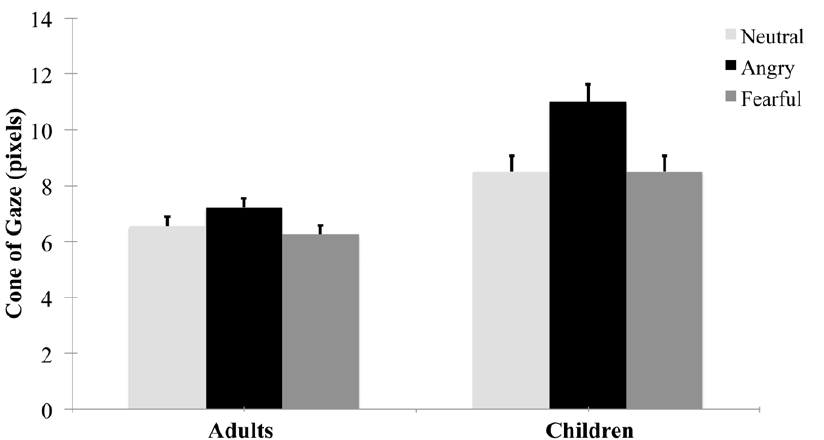
Figure 2. Untransformed cone of gaze values for each expression for children and adults. Error bars show ± 1 SE.